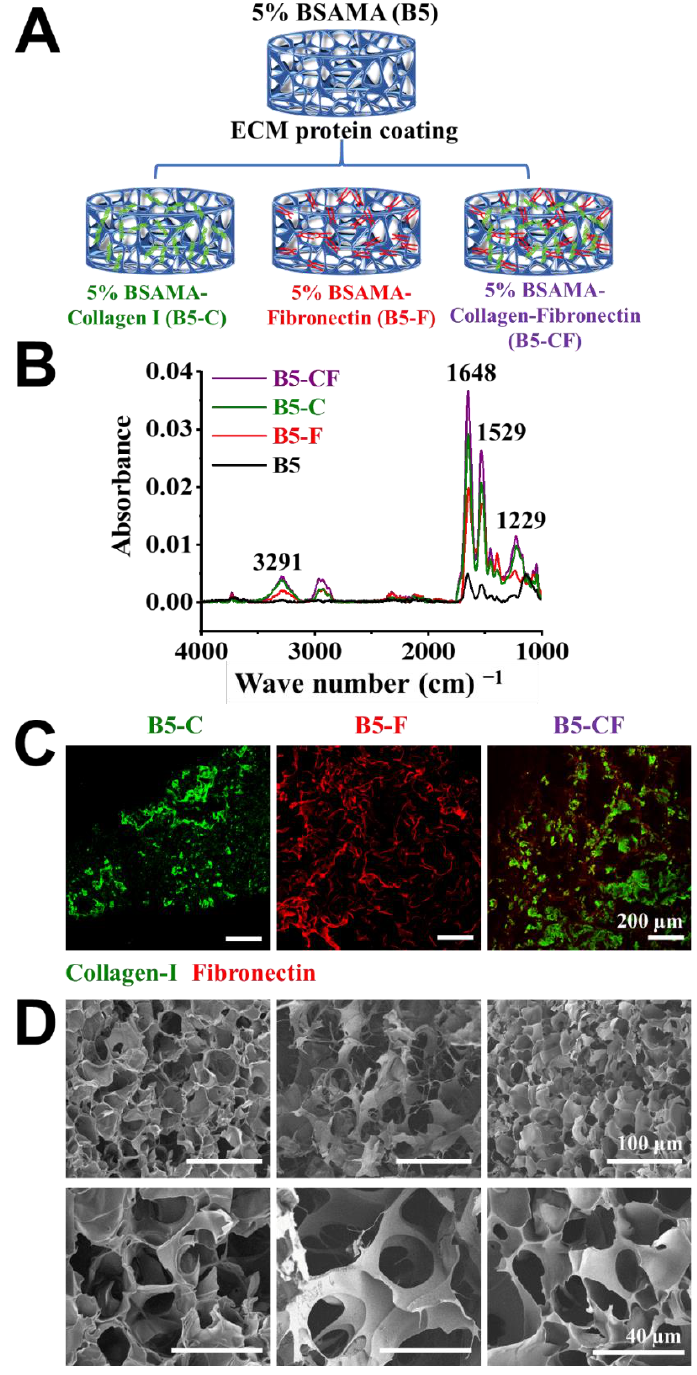
Figure 5. Preparation and characterization of ECM-coated BSAMA cryogels. ( A ) Schematic illustration presenting the preparation of 5% BSAMA – collagen I (B5-C), 5% BSAMA – fibronectin (B5-F), 5% BSAMA – collagen I – fibronectin (B5-CF). ( B ) FTIR spectra of unmodified and ECM protein-modified BSAMA cryogels. The broad peaks at 3118 – 3490 cm −1 resulting from a N-H stretching frequency of amine groups (-NH2). Peaks at 1648 cm −1 , 1529 cm −1 , and 1229 cm −1 correspond to the stretching/bending of amide-I, amide-II, and amide-III groups, respectively. ( C ) Immunostaining of collagen I and fibronectin in the ECM-coated BSAMA cryogels. Collagen I was stained with DyLight 488 (Green) and fibronectin was stained with DyLight 594 (red). Scale bar: 200 μm. ( D ) SEM images of ECM-modified BSAMA cryogels for ensuring that the overall porous structure of the cryogels appeared intact even after the coating. Scale bar: 100 μm (top); 40 μm (bottom).